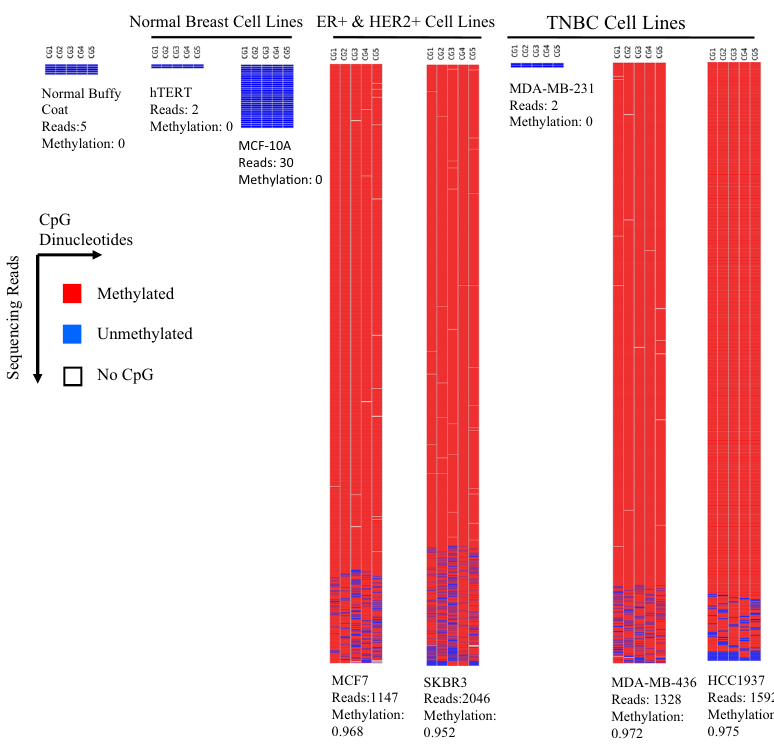
Fig. 3 Singleplex sequencing results for the probe NFIC-A in cell lines. Shown here are the BiQ Analyser generated heatmaps of the NGS reads for the probe NFIC-A as analysed in numerous cell lines. Each column represents one of the 5 CpG dinucleotide in the ampli fi ed region while each row indicates an individual sequencing read. Blue fi ll indicates that the CpG dinucleotide was not methylated in a particular read while red fi ll indicates that the CpG dinucleotide was methylated in a particular read. The number of reads and the fraction that are methylated in each probe is indicated below each map. As expected, there is low methylation in the immortalised mammary epithelial cell lines 184-hTERT and MCF-10A, as well as the normal buffy coat DNA. Two of three TNBC cell lines (MDA-MB-231, MDA-MB-436, and HCC1937) were methylated demonstrating heterogeneity between individual cancers. Furthermore, MCF7 and SKBR3, an ER + and HER2 + cell line show methylation, indicating that the probe is not exclusively methylated in TNBC but also in other subtypes of cancer. In general, methylation was an all or none phenomena.